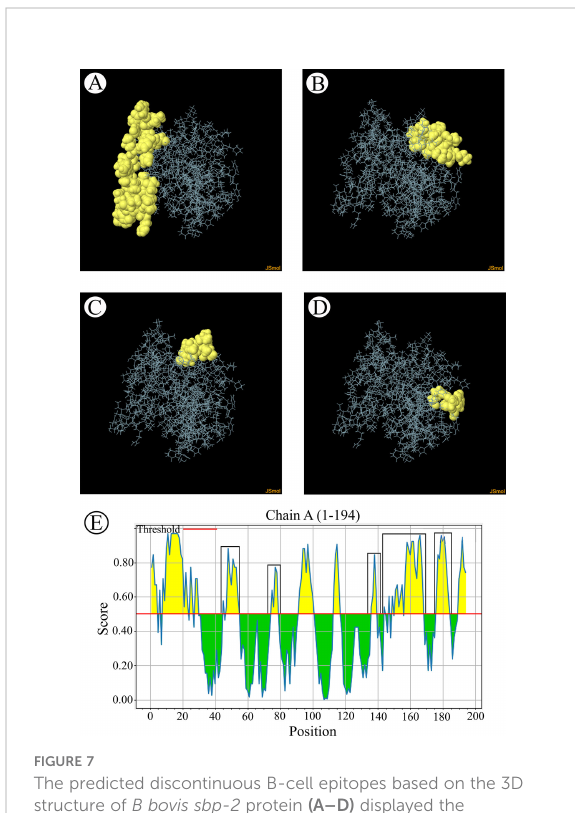
FIGURE 7 The predicted discontinuous B-cell epitopes based on the 3D structure of B bovis sbp-2 protein (A – D) displayed the overlapping region in the same position as the B-cell linear structure prediction (E) .